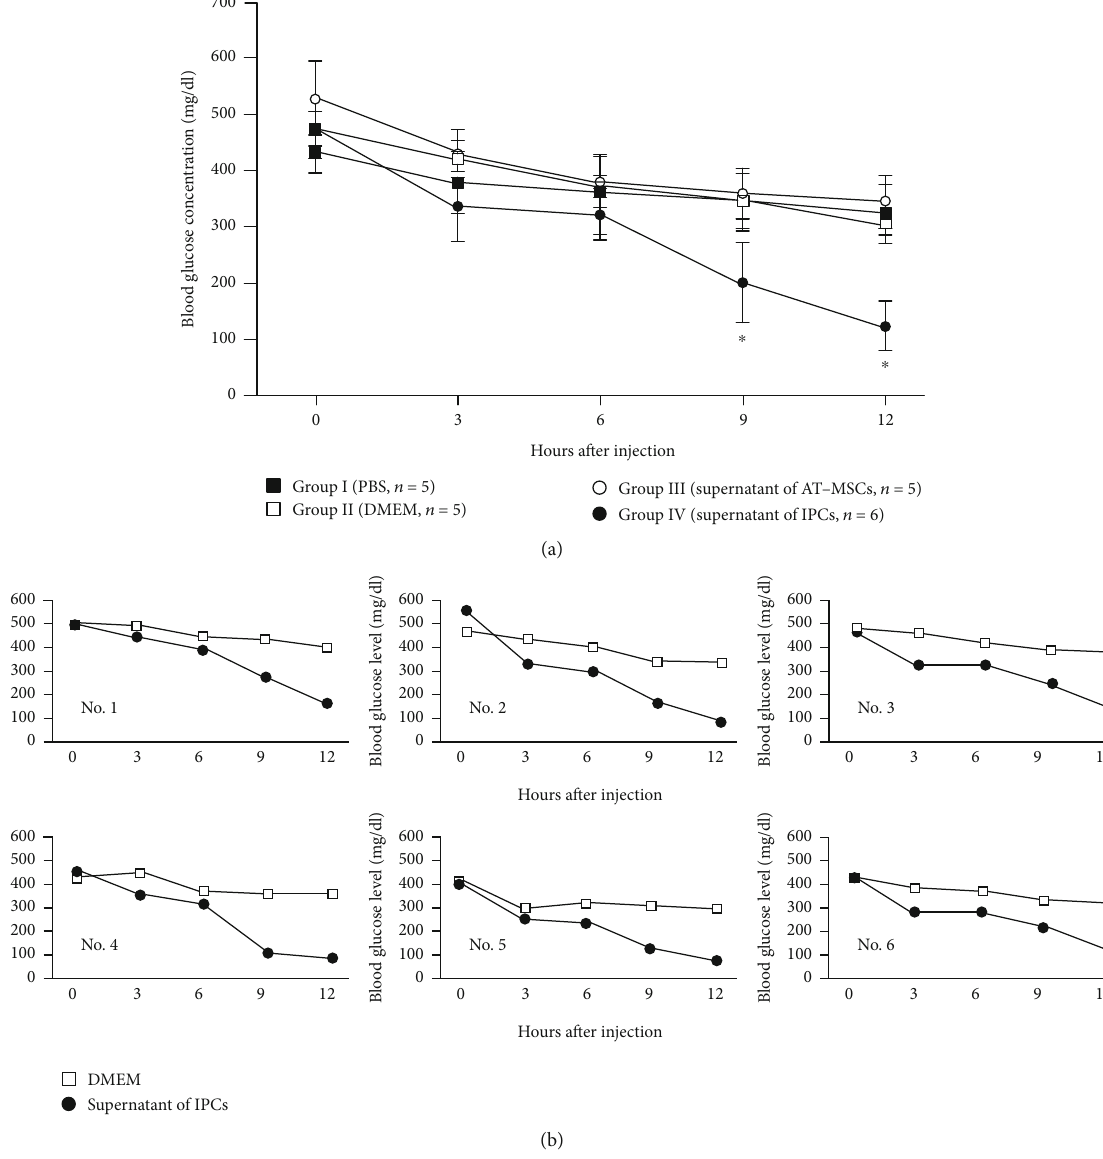
Figure 5: Blood glucose levels in diabetic mice after injection with various treatments. (a) Comparison among groups. The blood glucose levels at 9 and 12h after injection in group IV (supernatant of IPCs) were signi fi cantly lower compared with those in groups I (PBS), II (DMEM), and III (supernatant of AT-MSCs). Data are expressed as the mean ± standard deviation . ∗ P < 0 : 05 vs. groups I, II, and III. (b) Comparison of the blood glucose levels in the same mice after injection with the supernatant of IPCs and DMEM. The blood glucose levels were lower after injection with the supernatant of IPCs in all six